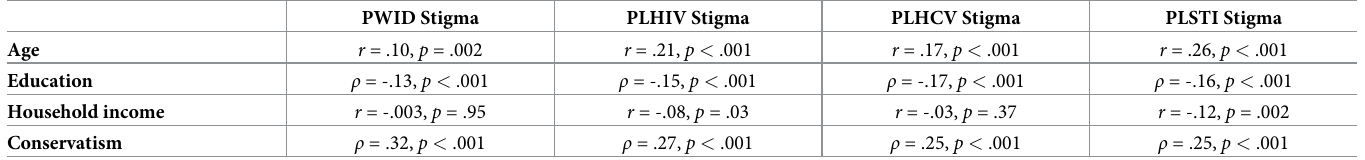
The final multiple regression model with PLHIV stigma as the dependent variable is shown in Table 4. Table 3. Correlations between socio-demographic variables and people who inject drugs, people living with HIV, people living with hepatitis C, and people living with sexually transmissible infections stigma scale